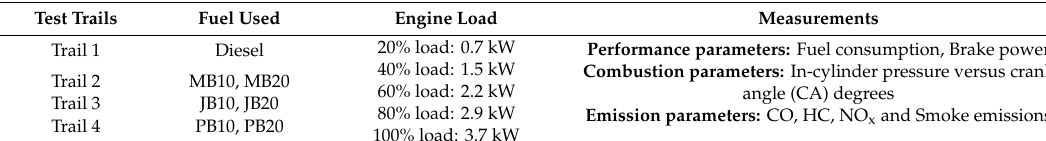
Table 5. Detailed experimental test matrix.